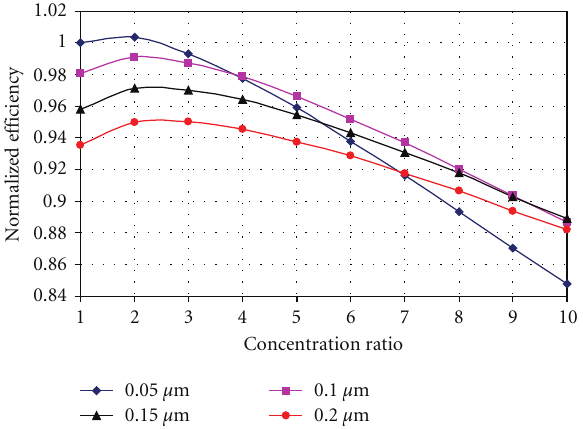
Figure 6: Normalized plot of the Junction depth-optimized solar cells (plot normalized with the highest e ffi